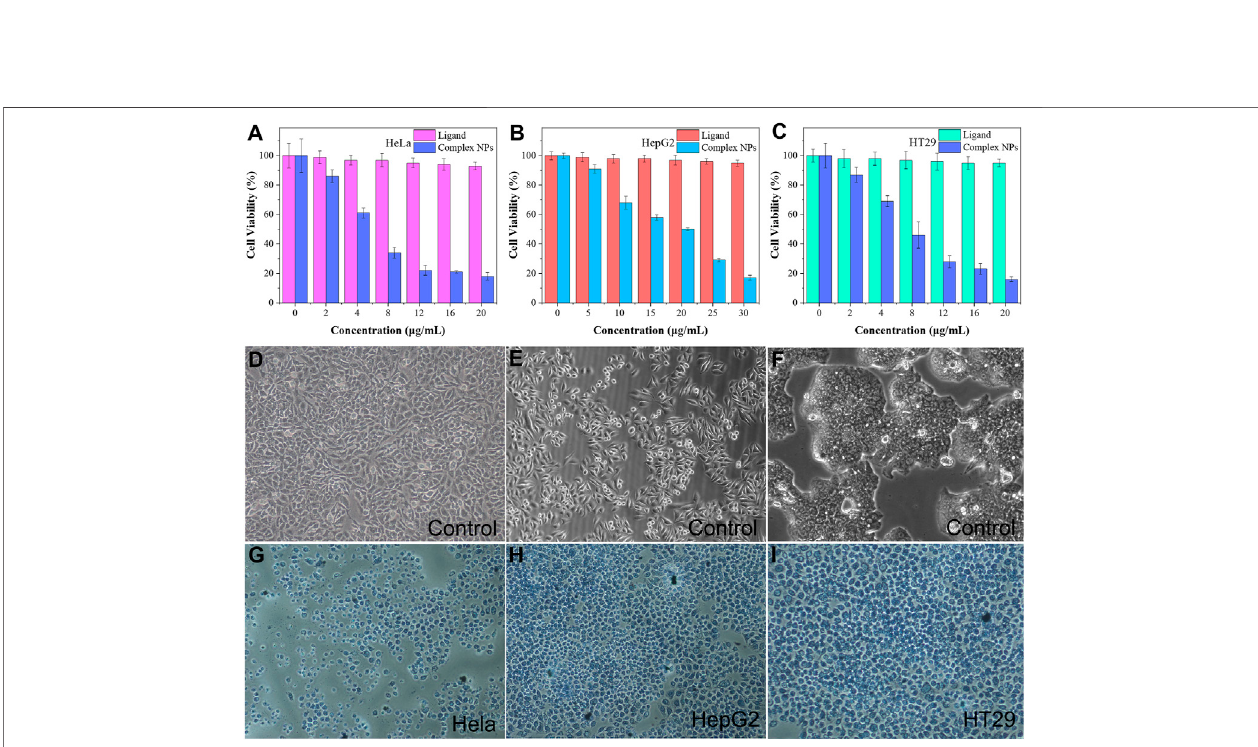
FIGURE6|(A – C) InvitroMTTassayofHeLa,HepG2,andHT29cellswastreatedwithligandH4LandcomplexNPs;trypanblue fl uorescentstainingofthecontrol group for (D) HeLa cells, (E) HepG2 cells, and (F) HT29 cells; Complex NPs for (G) HeLa cells (H) HepG2 cells (I) HT29 cells.